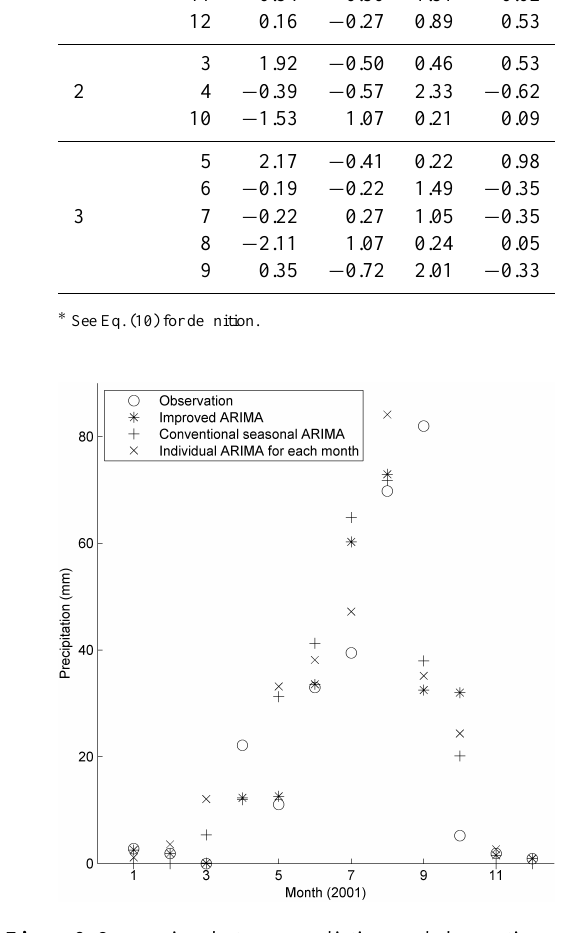
difference from that of AR(36) model; neither models per- form as good as the improved ARIMA model or the conven- tional ARIMA model. However, the AR models give a better prediction for September precipitation of 2001 than the other two models. While the improved ARIMA model catches the correct trend overall and predicts the monthly precipitation in most months with high accuracy, it predicts highly accurately for the dry seasons, such as January, February, March, Novem- ber, and December. However, it overestimates the precipi- tation of July and October and underestimates the Septem- ber precipitation significantly. After a closer look at the data, we find that the mean precipitations of July and October are 63.8 and 23.48 mm over the period of 1951 through